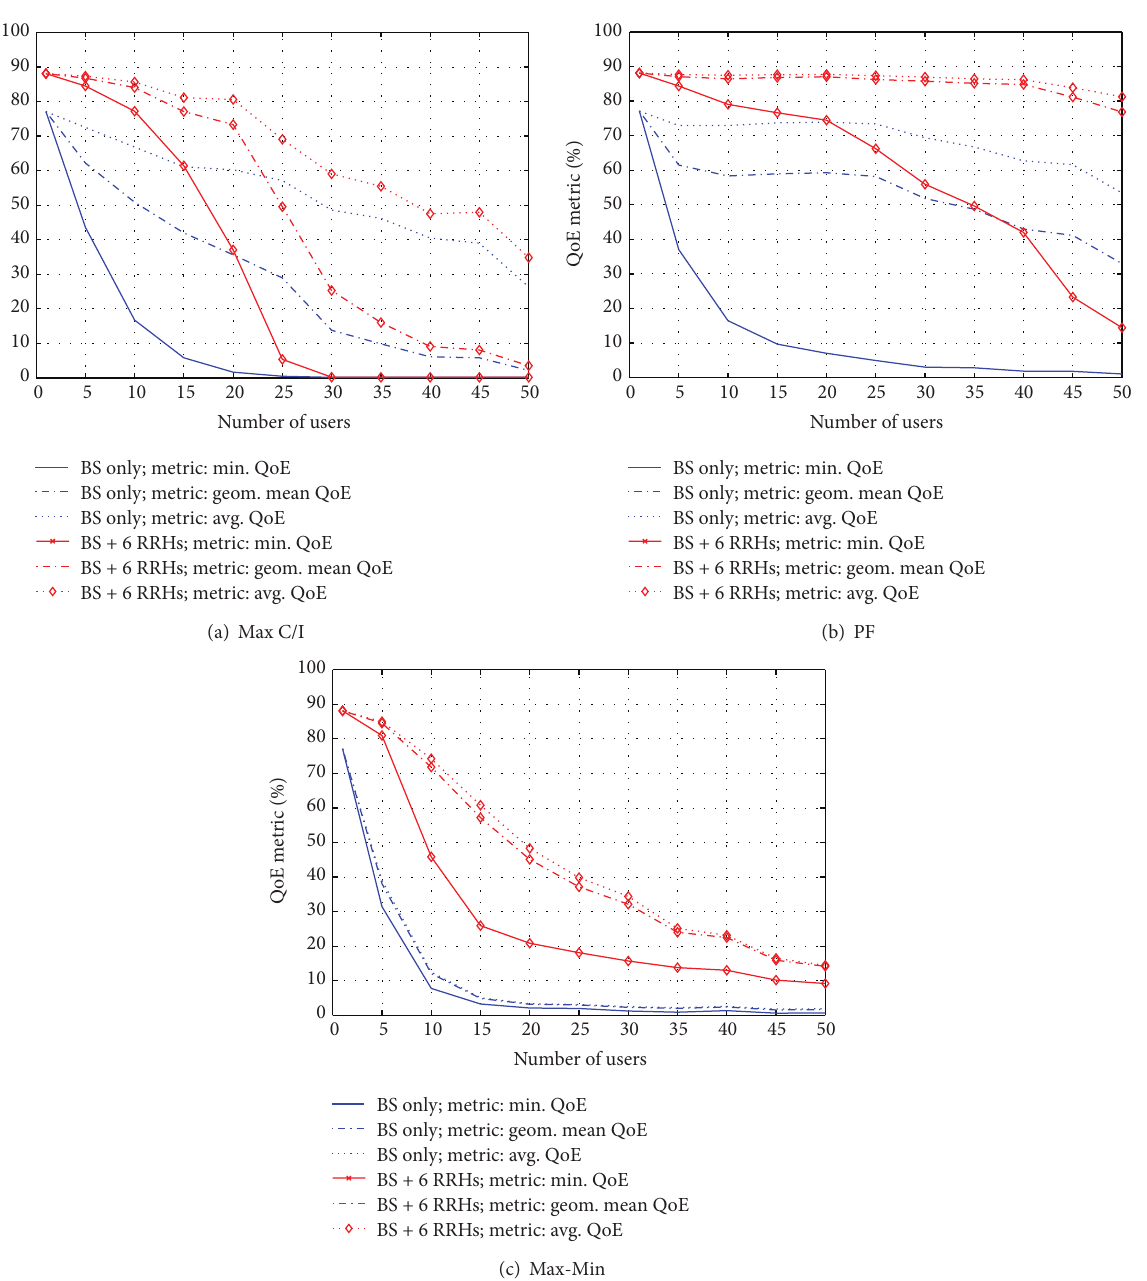
Figure 7: UL QoE results with